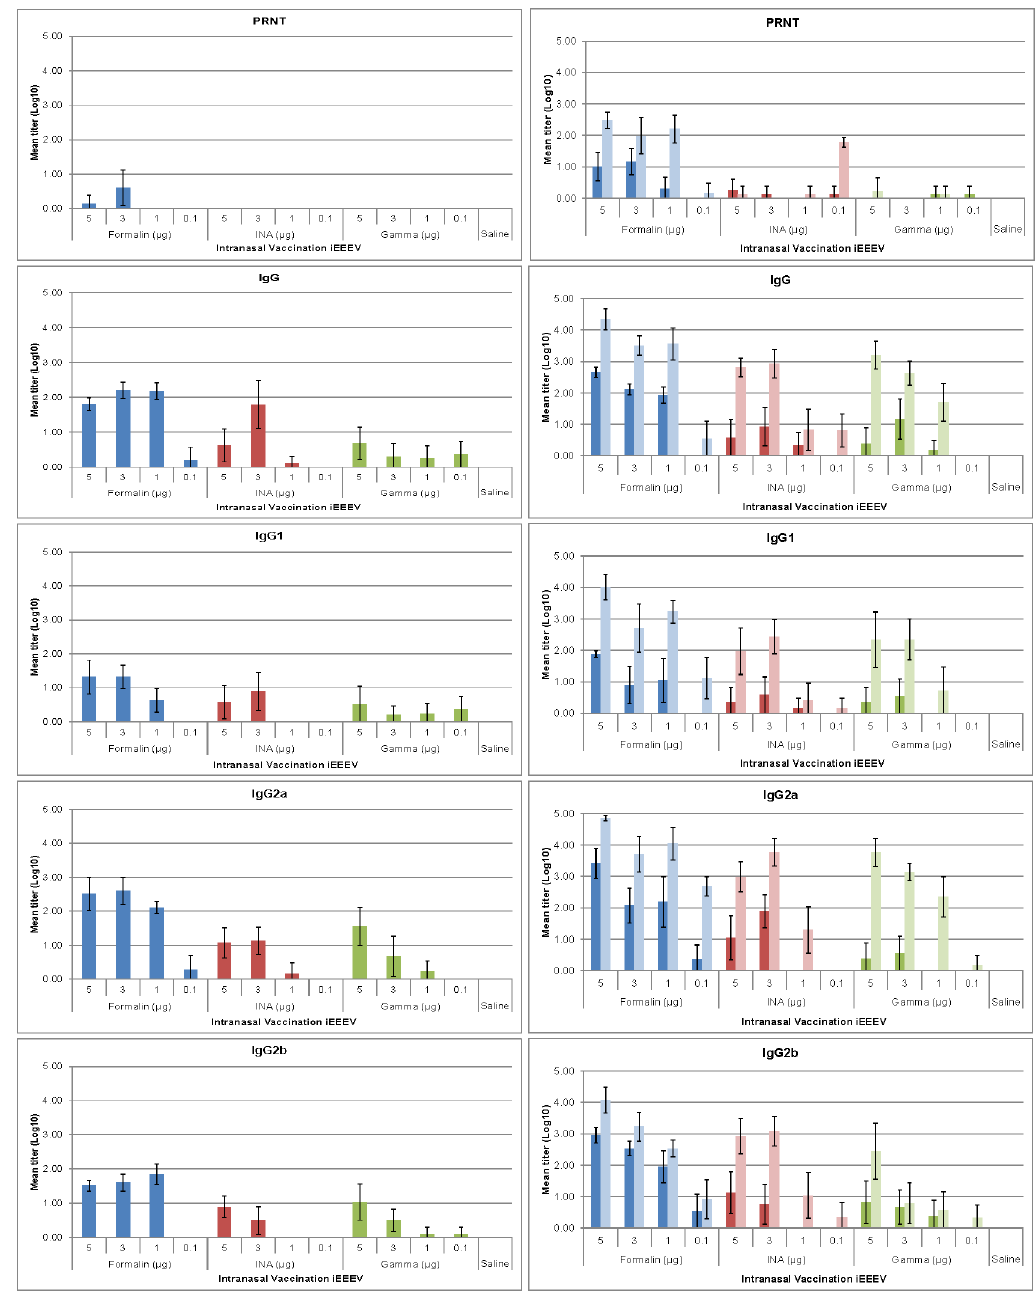
Figure 4. Serum antibody responses in mice vaccinated intranasally with iEEEV vaccine candidates. Groups of BALB/c mice (n=10) were vaccinated once (graphs on left) or twice (graphs on right) with one of three iEEEV vaccine candidates (formalin-inactivated, INA-inactivated, or gamma irradiated) at doses ranging from 5–0.1 m g by the IN route. Serum was collected 21 d after each vaccination. Neutralizing antibody responses were determined by PRNT and serum antibody levels were determined by ELISA. In all graphs, dark bars represent the mean group titer 21 d after the first vaccination (n=10); light bars represent the mean group titer 21 d after the second vaccination (n=10). Standard error bars represent 2 times the SE of the mean (SE=SDxsqrt(n)). dilution with an 80% or greater reduction (PRNT 80) of the number of plaques observed in control wells. The assay limit of detection was calculated to be 5 pfu/ml by this method.